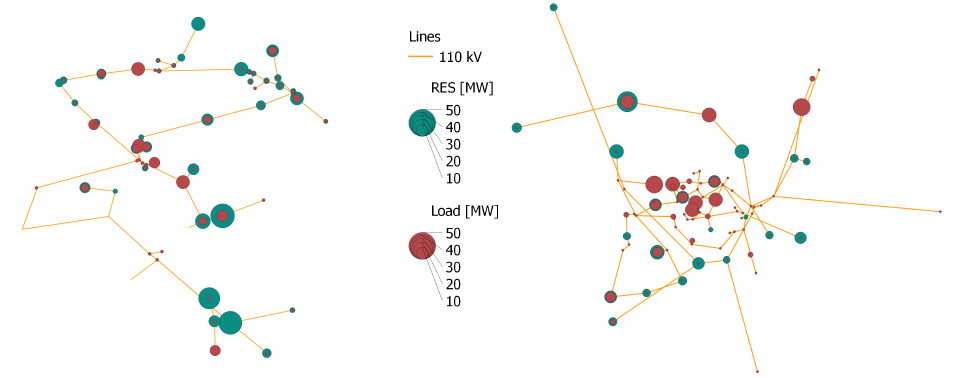
Figure 3. Distribution of installed generation capacities and loads in the mixed ( left ) and the urban ( right ) HV